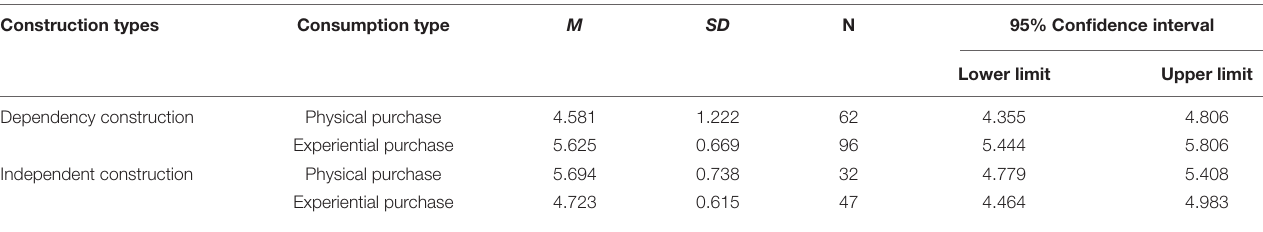
TABLE 2 | Descriptive statistics of the difference in